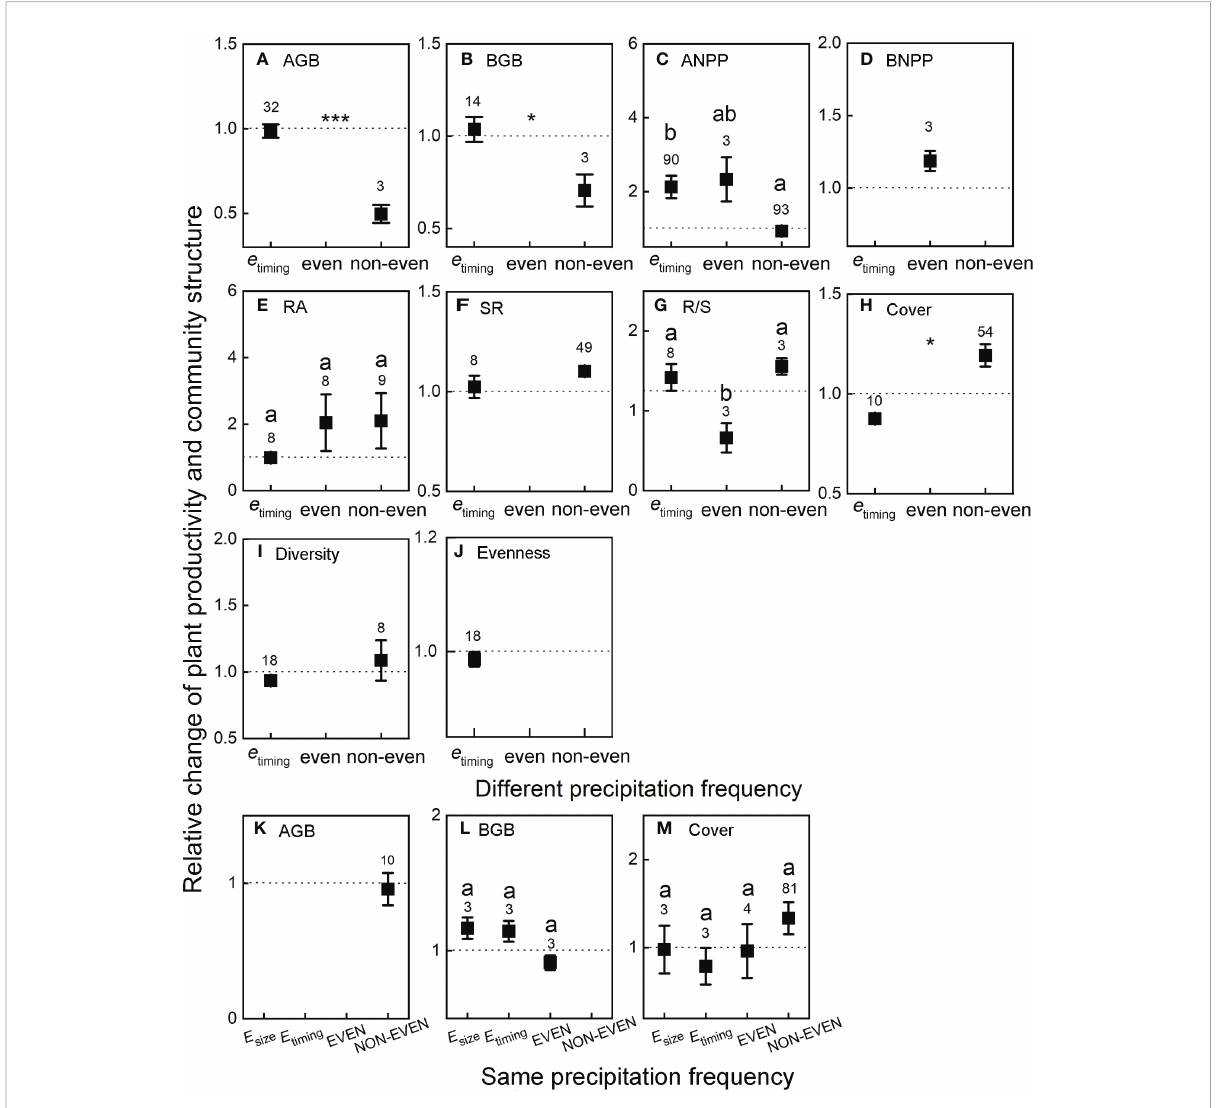
FIGURE 5 Treatment effects on plant productivity and community structure relative to the ambient in different precipitation frequency (A – J) and same precipitation frequency (K – M) . Data are reported as mean ± SE and numbers indicate the number of data observations. The dotted lines indicate the reference line for treatment intensity. Signi fi cant differences among treatments are indicated by different lettering ( p < 0.05) and * (* p < 0.05, *** p < 0.001). See Figure 2 and Figure 3 for